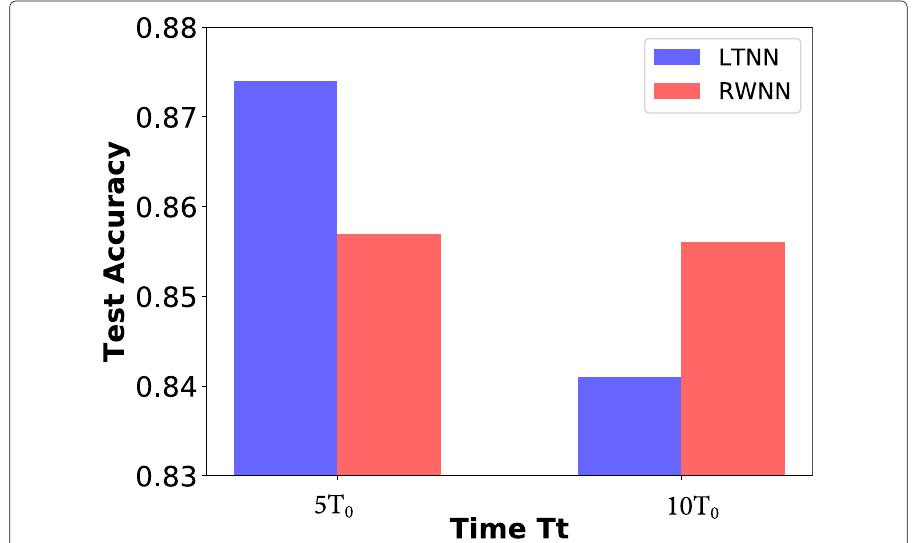
Fig. 11 Performance of Different Time